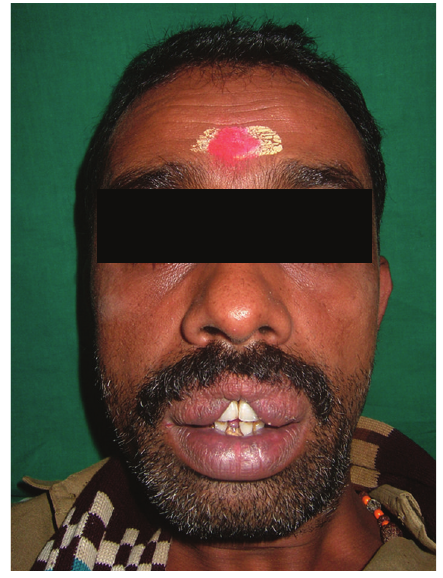
Figure 1: Pre-operative patient’s photograph.